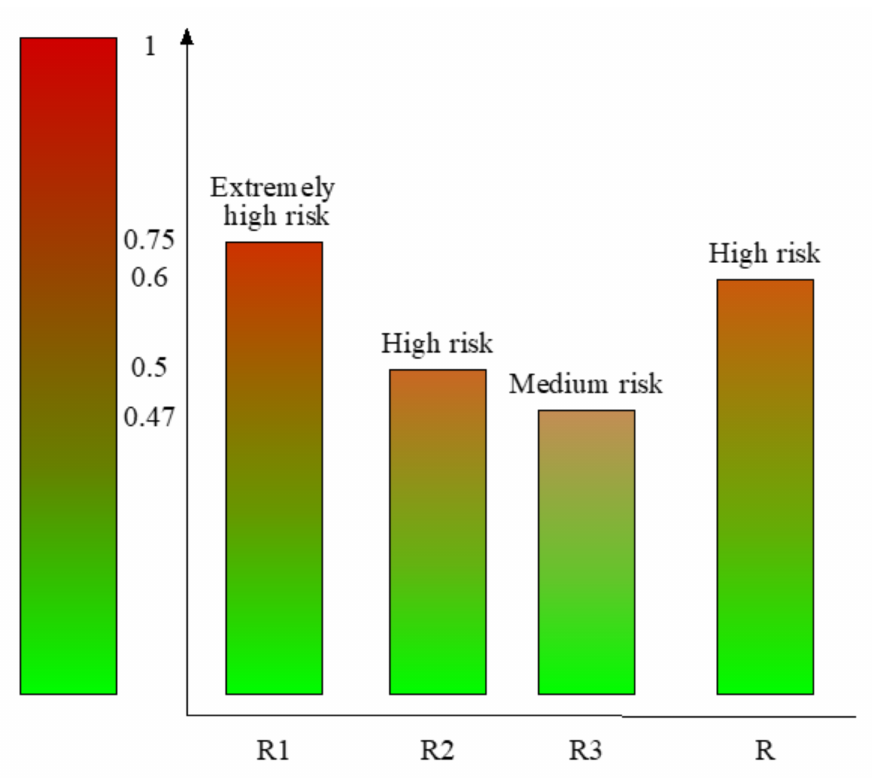
Figure 10. Risk indices and risk levels for the case